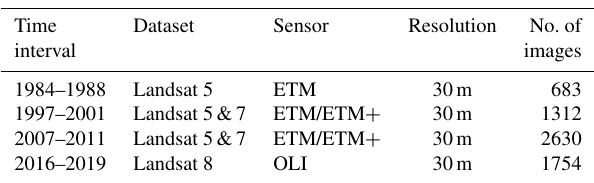
Table 1. Dataset and the resolution of the dataset used for each time step. Time Dataset Sensor Resolution No. of interval